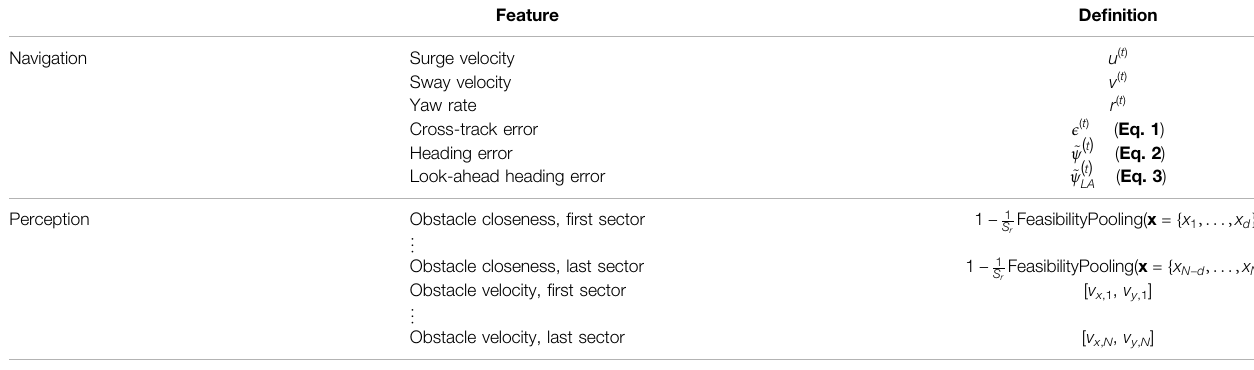
TABLE 1 | RL agent ’ s observation vector at each time step t (Meyer et al., 2020a). The FeasibilityPooling algorithm calculates the maximum reachable distance in a given sector for therange fi ndersuite.Obstacle velocities arerelativetothebody framerotated such thatthelongitudinalaxis isparallel tothecenterline ofthegiven sector and describe the velocity of the closest obstacle in that sector. Static obstacles assume a relative velocity of zero.